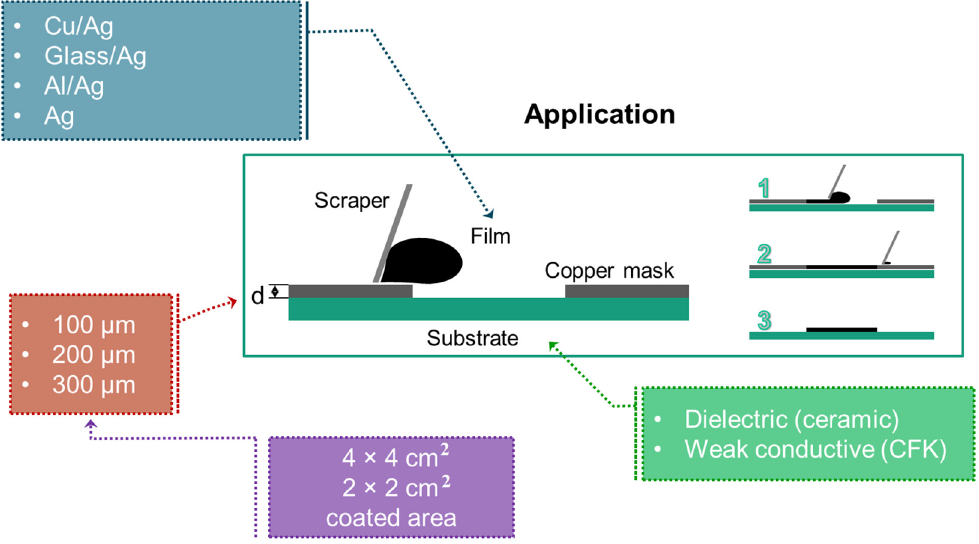
Figure 3. Schematic of the frame printing technique.